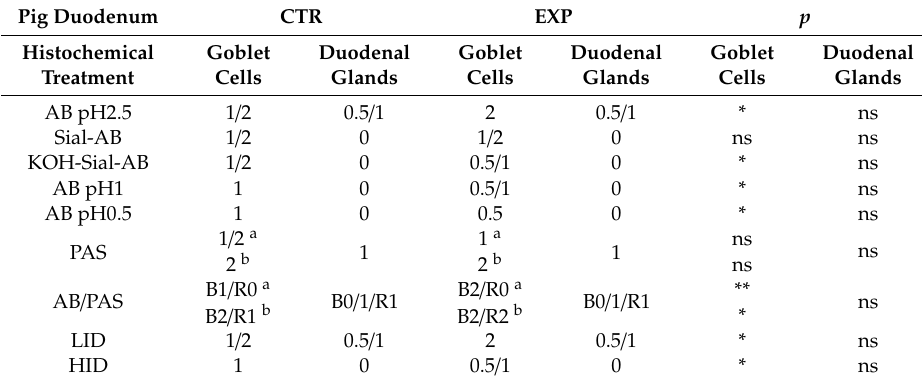
Table 2. Responses of pig duodenum secretory structures.